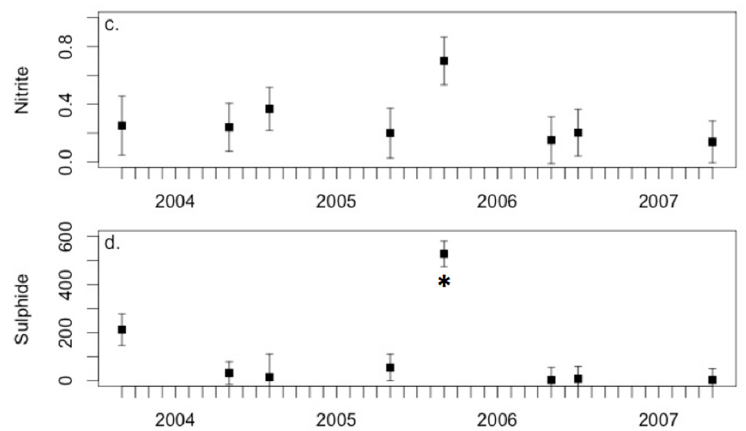
Figure 8. Sediment chemistry least square means over the study period. ( a ) Ammonia; ( b ) nitrate; ( c ) nitrite, and ( d ) sulfide fluctuated over the study period. Asterisks (*) denote timeframes with statistically high conditions and error bars denote standard errors.